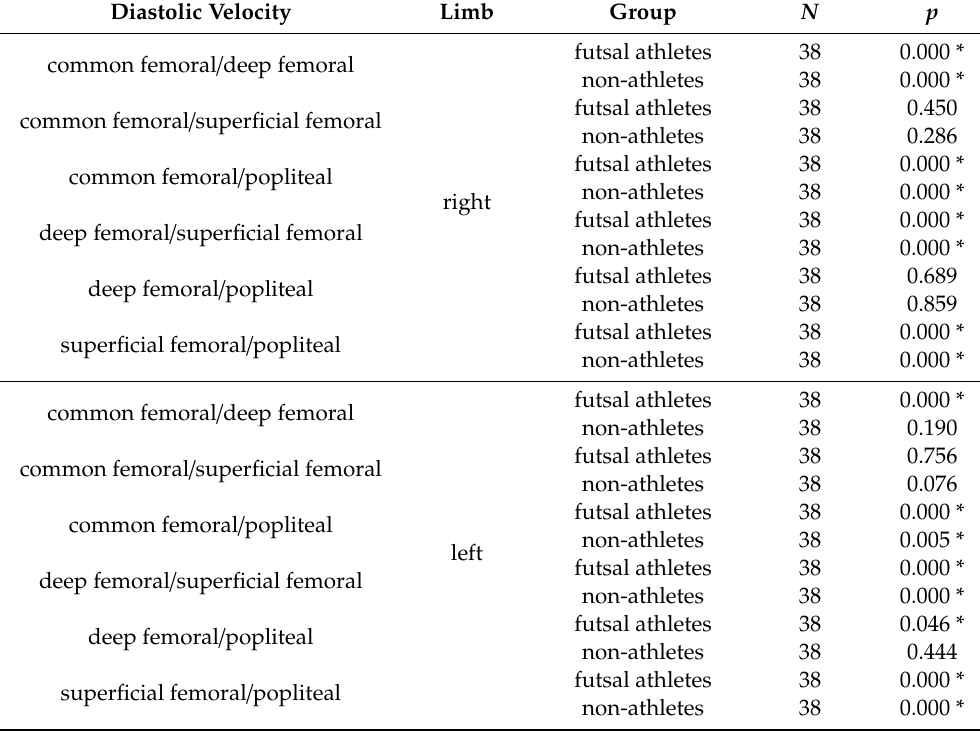
Table 3. Pairwise comparisons in diastolic velocities between arteries in the right and left limbs on non-athletes and futsal